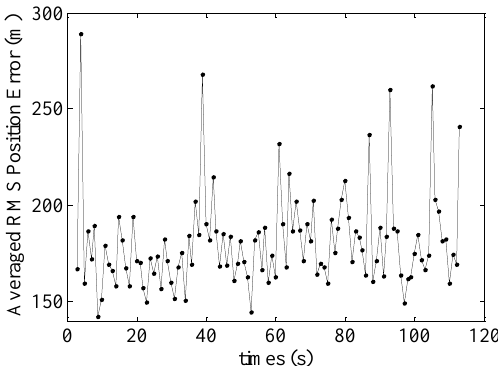
Figure 14. The estimated error for the target II.